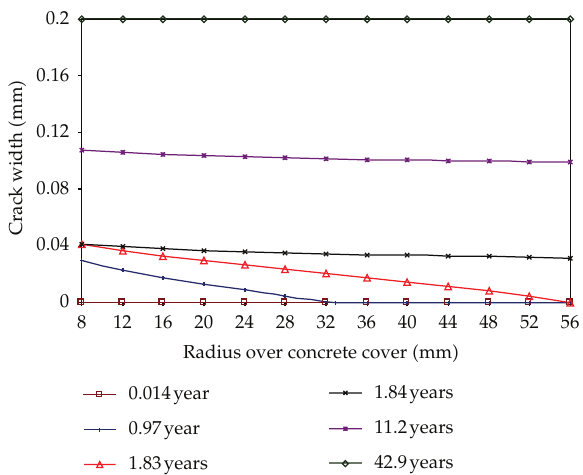
Figure 10: Crack width (cid:5) w (cid:6) varying over concrete cover at various